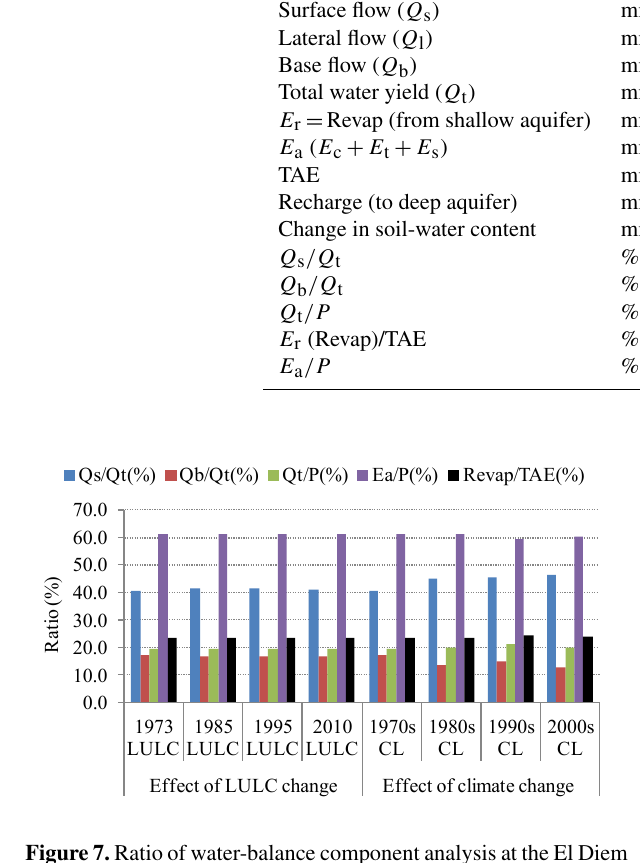
Figure 7. Ratio of water-balance component analysis at the El Diem station using an isolated effect (LULC/climate